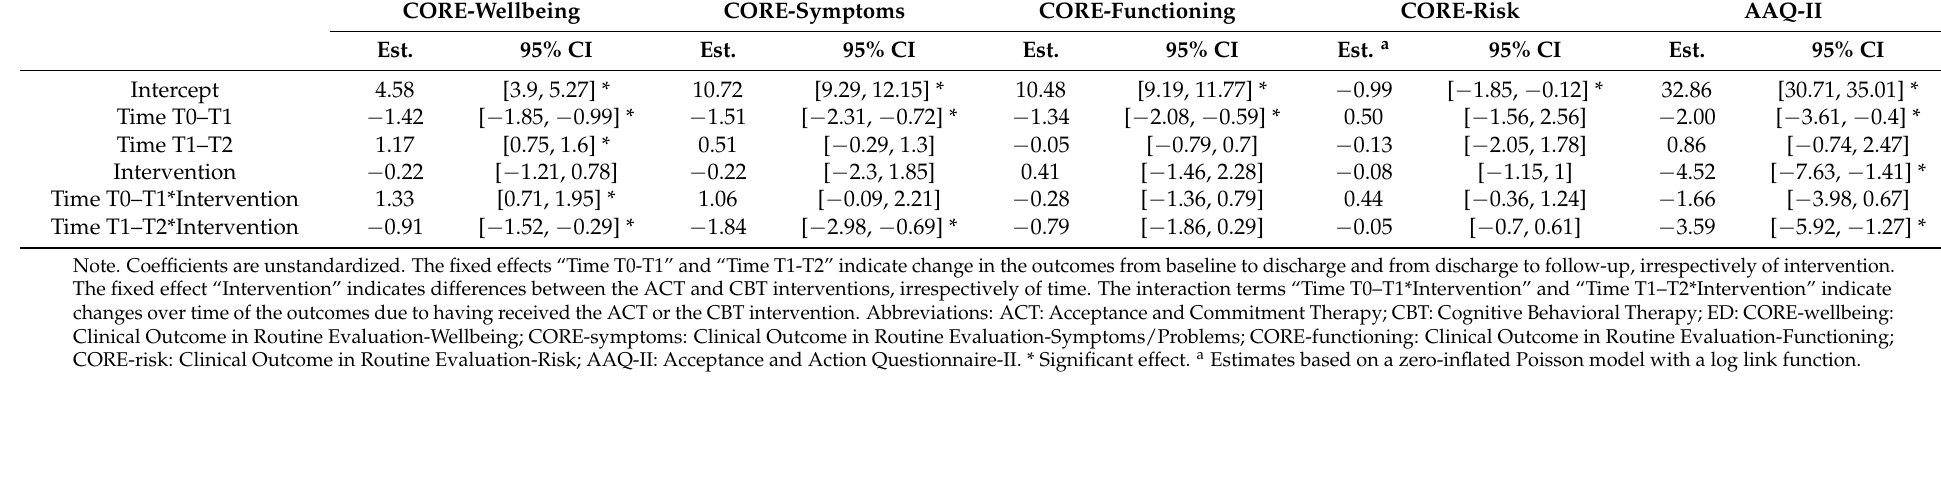
Table 4. Results of the generalized linear mixed models comparing the effects of the ACT and CBT treatments over time on the subscales of the CORE-OM and on the AAQ-II. CORE-Wellbeing CORE-Symptoms CORE-Functioning CORE-Risk AAQ-II Est. 95% CI Est. 95% CI Est. 95% CI Est. a 95% CI Est. 95% CI Intercept 4.58 Time T0–T1 Time T1–T2 1.17 − 0.13 0.86 [ − 0.74, 2.47] Intervention − 0.22 [ − 1.21, 0.78] − 0.22 Time T0–T1*Intervention 1.33 Time T1–T2*Intervention −